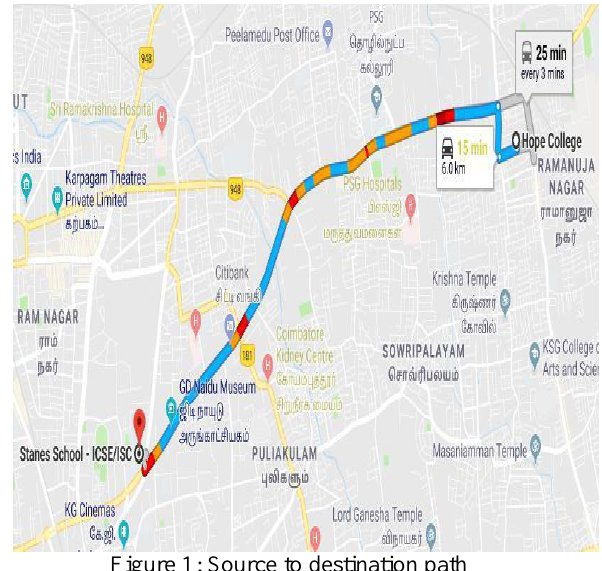
Figure 1: Source to destination